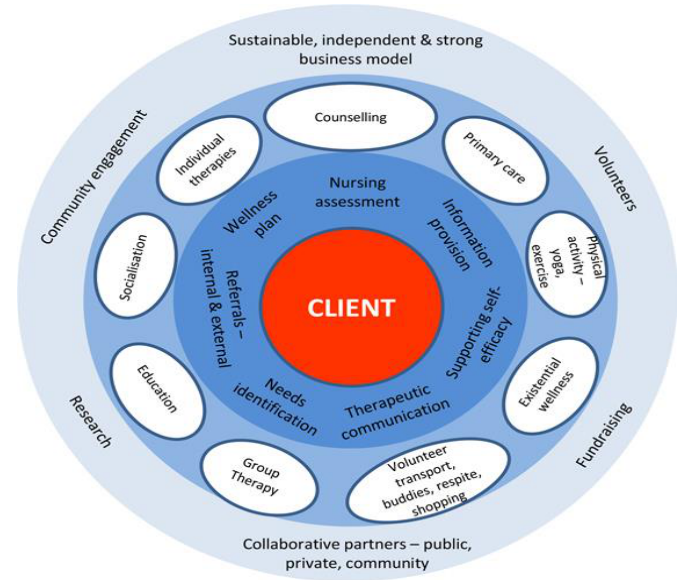
Figure 1. Bloomhill Cancer Center (BCC) Integrated Cancer Care Model.